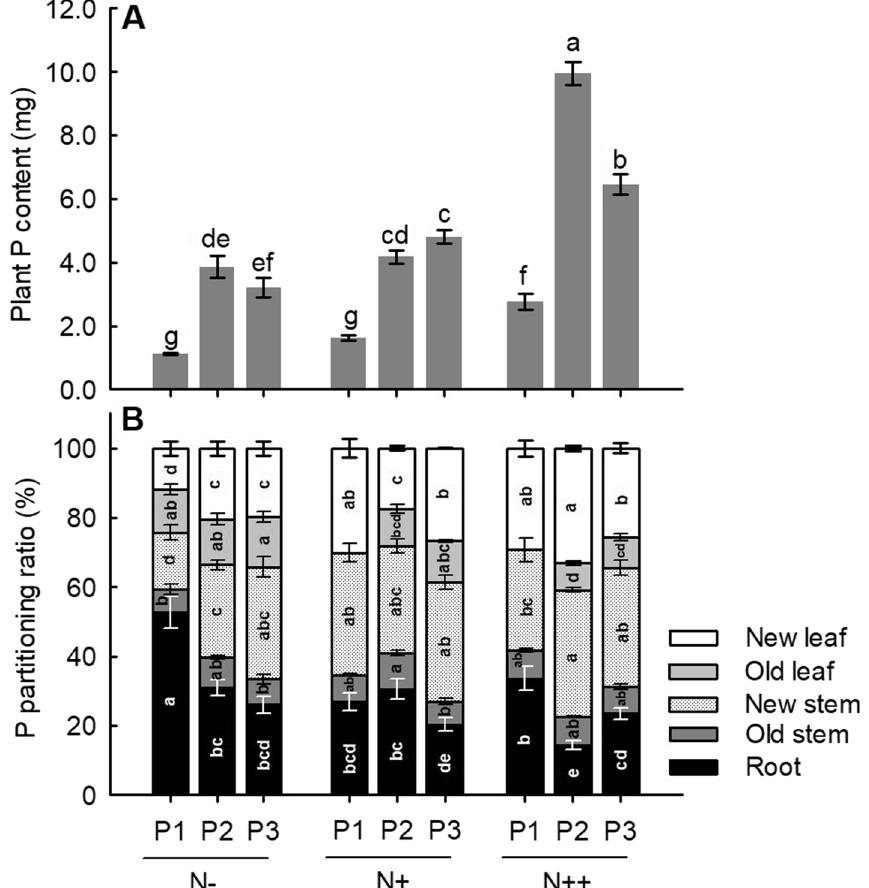
Fig. 2 Plant P content ( A ) and P partitioning ratio ( B ) of P. edulis seedlings in response to experimental N deposition rate under different soil P availability. Different lowercase letters in panel A represent significant differences among different treatments (Tukey’s HSD, α lowercase letters in the same component in panel B represent significant differences among different treatments (Tukey’s HSD, α bars represent standard error from the mean at each sampling ( n